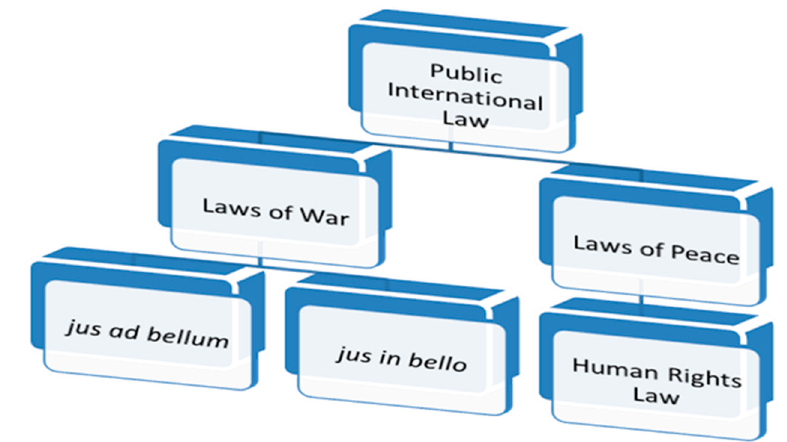
Figure 1. Traditional View of the Laws of War and Peace.